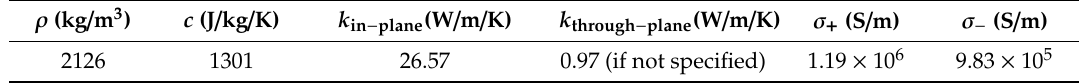
Table 1. Physical properties for the lithium-ion battery